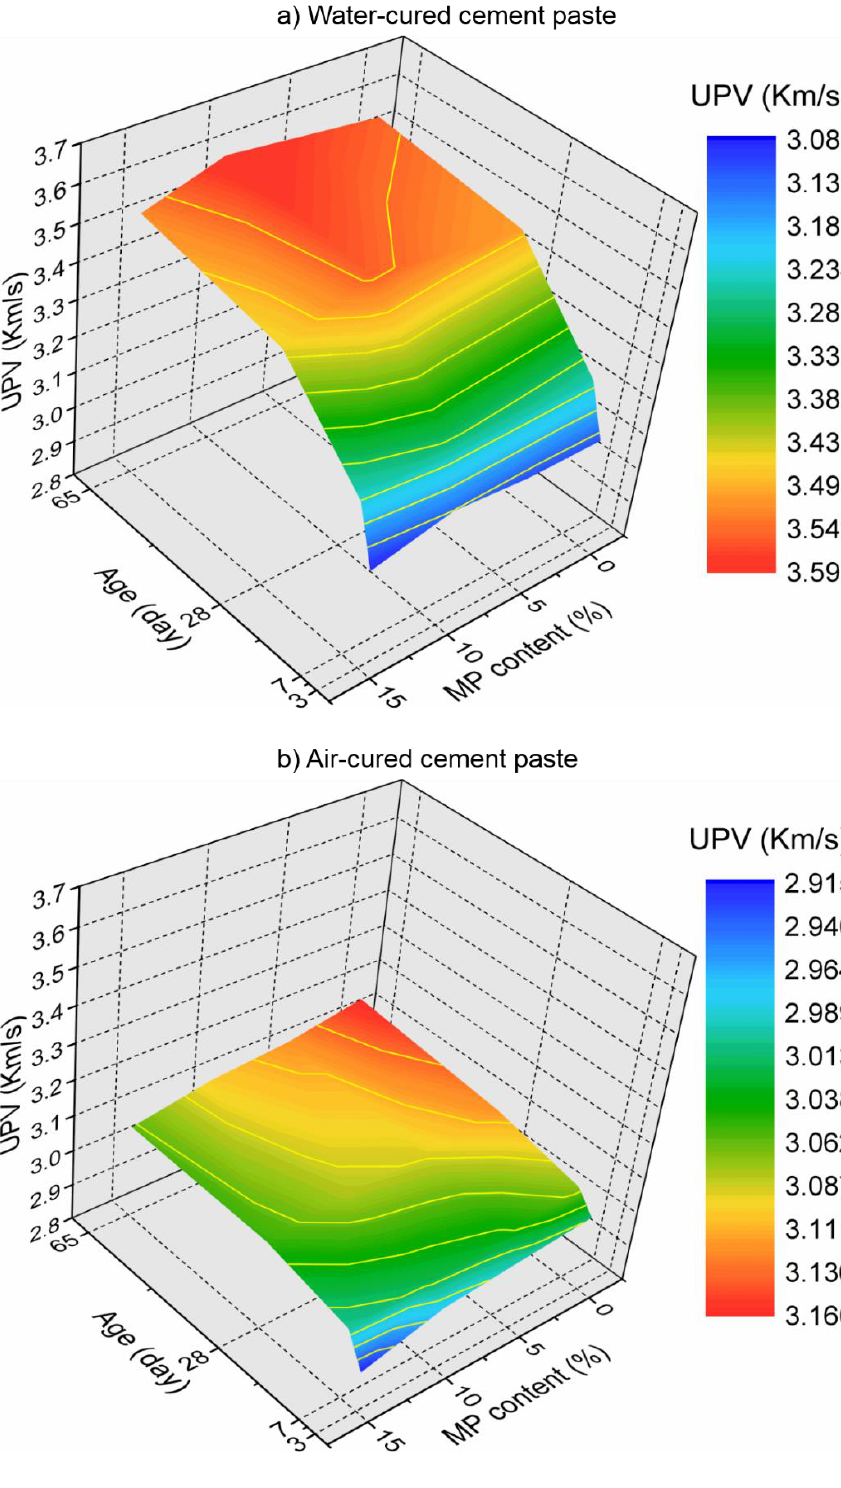
Figure 4. Effect of the incorporation of MP on cement paste ’s UPV at 3 to 65 days, ( a ) water-cured Figure 4. E ff ect of the incorporation of MP on cement paste’s UPV at 3 to 65 days, ( a ) water-cured cement paste; ( b ) air-cured cement paste. cement paste; ( b ) air-cured cement